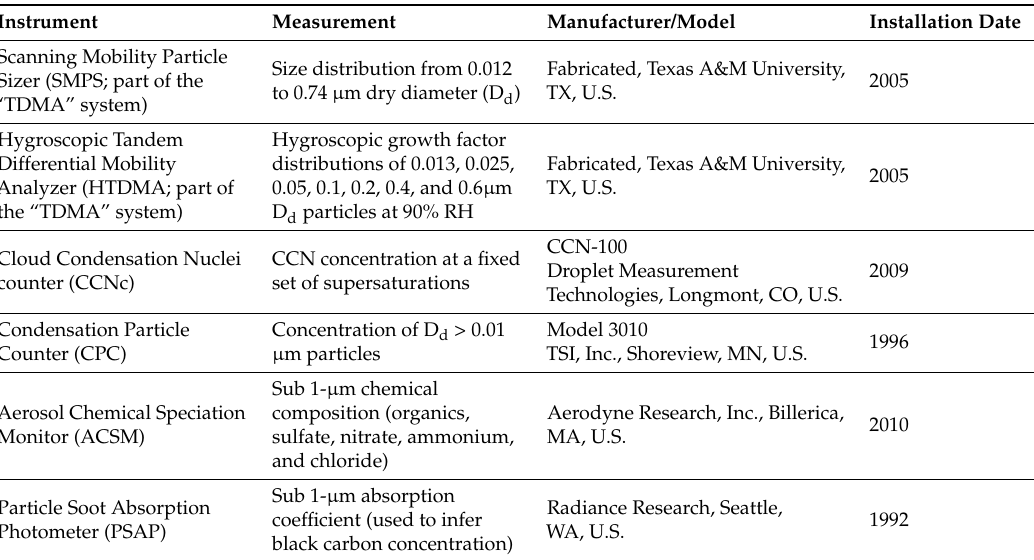
Table 1. List of instruments, measured quantities, manufacturer, and year installed. Instrument Measurement